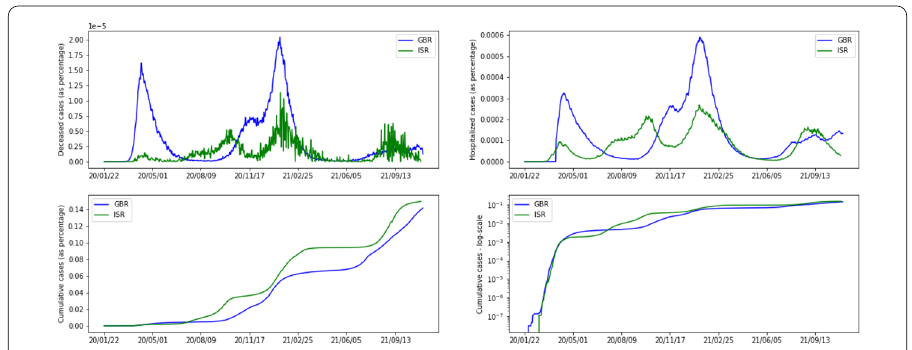
Figure 2 Ground truth attributes. In each subfigure, y -axis represents values in terms of population percentage for each country, while x -axis provides the dates for the corresponding data. Upper left: new deceased cases at a given day. Upper right: hospitalized cases. Bottom left: cumulative count of confirmed cases. Bottom right: cumulative count of confirmed cases in a